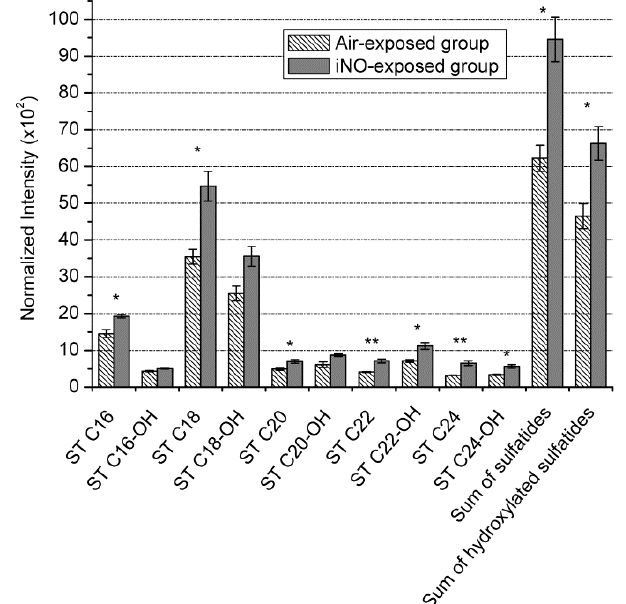
Figure 4. Mean relative intensities of 10 sulfatide ion peaks (non-hydroxylated and hydroxylated) and their sum calculated from a triplicate analysis of P10 rat brain tissues (exposed to air and iNO; n = 6 in each experimental group) with their standard